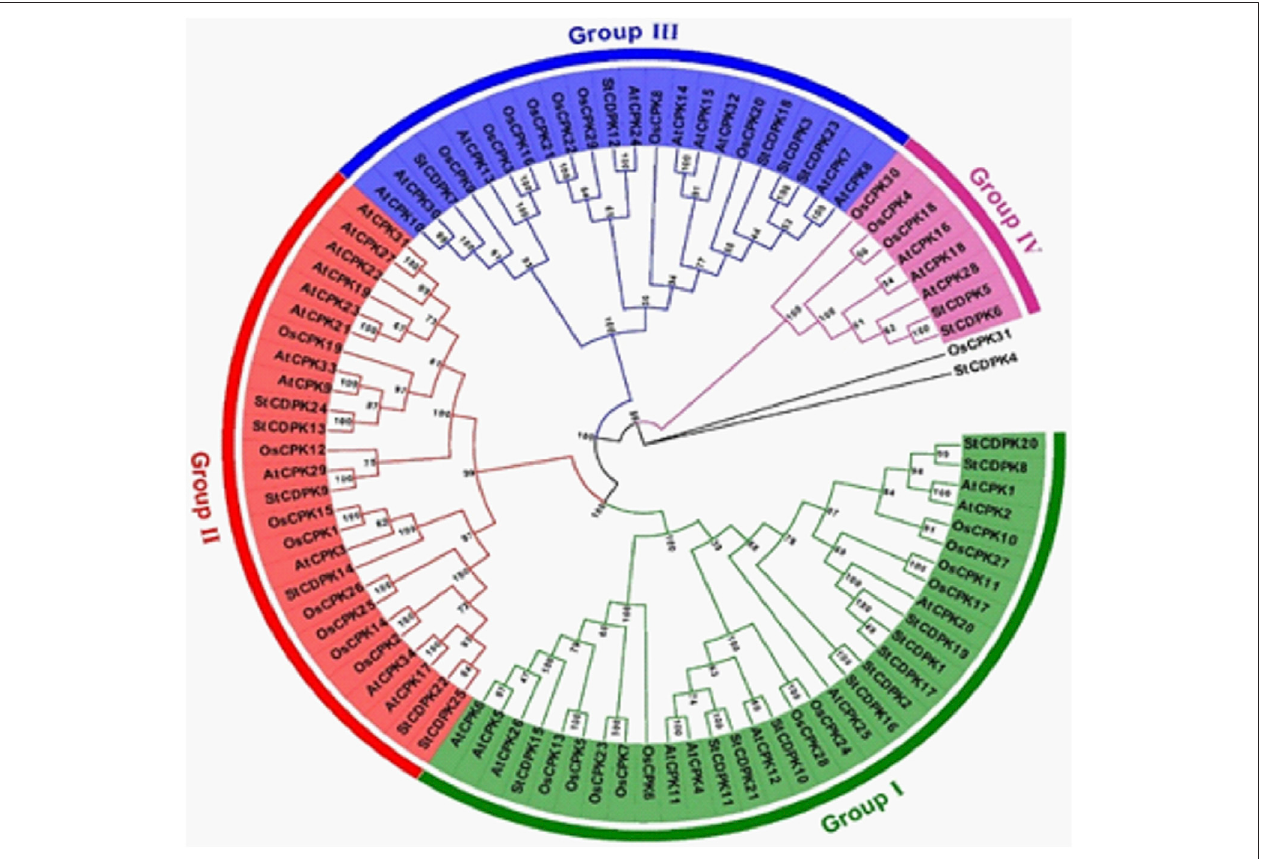
FIGURE 2 | Phylogenetic tree of CDPKs gene family in potato ( Solanum tuberosum ), rice ( Oryza sativa ), and Arabidopsis thaliana . The tree was generated using Mega7.0softwarebytheNeighbor-joiningmethodandbootstrapanalysis(1,000replicates)expressedinpercentages.Membersinthesamegroupareclusteredunder the same color with a chromosomal location number ranging from; StCDPK1 to 25 in potato, OsCPK1 to 31 in rice, and AtCPK1 to 34 in Arabidopsis